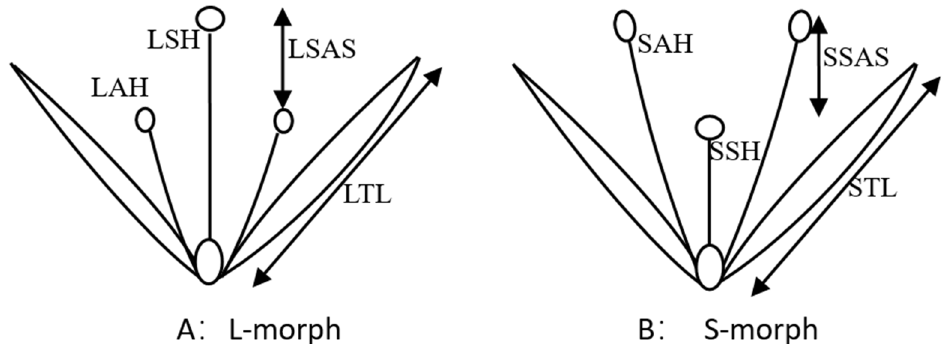
Figure 2. Pattern diagram of distylous flower of P. criopolitanum (( A ): L-morph; ( B ): S-morph). LTL: tepal length of L-morph; LAH: anther height of L-morph; LSH: stigma height of L-morph; LSAS: stigma-anther separation of L-morph; STL: tepal length of S-morph; SAH: anther height of S-morph; SSH: stigma height of S-morph; SSAS: stigma-anther separation of S-morph.